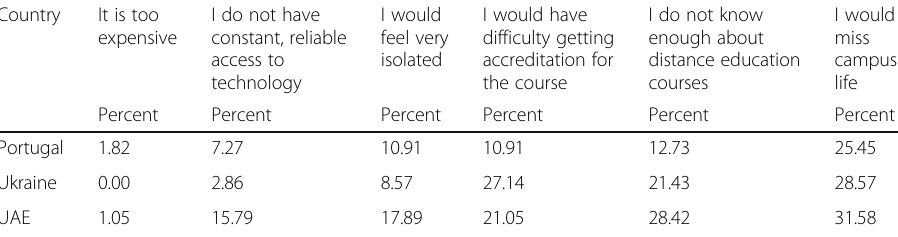
Table 5 Reasons to not enroll in distance education courses (More than one could be chosen)